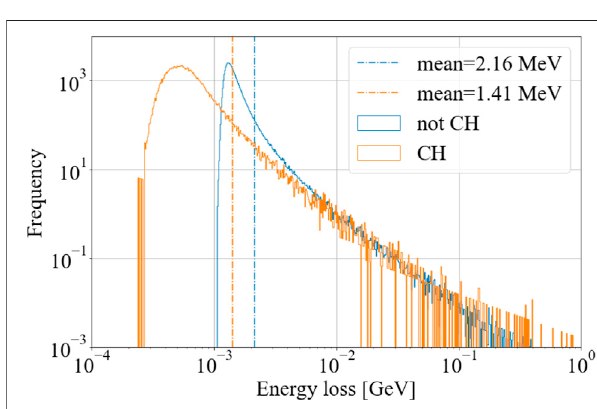
FIGURE 2 | Energy loss distribution for 180 GeV protons on a 4 mm- long crystal in channeling regime (orange) and in amorphous regime